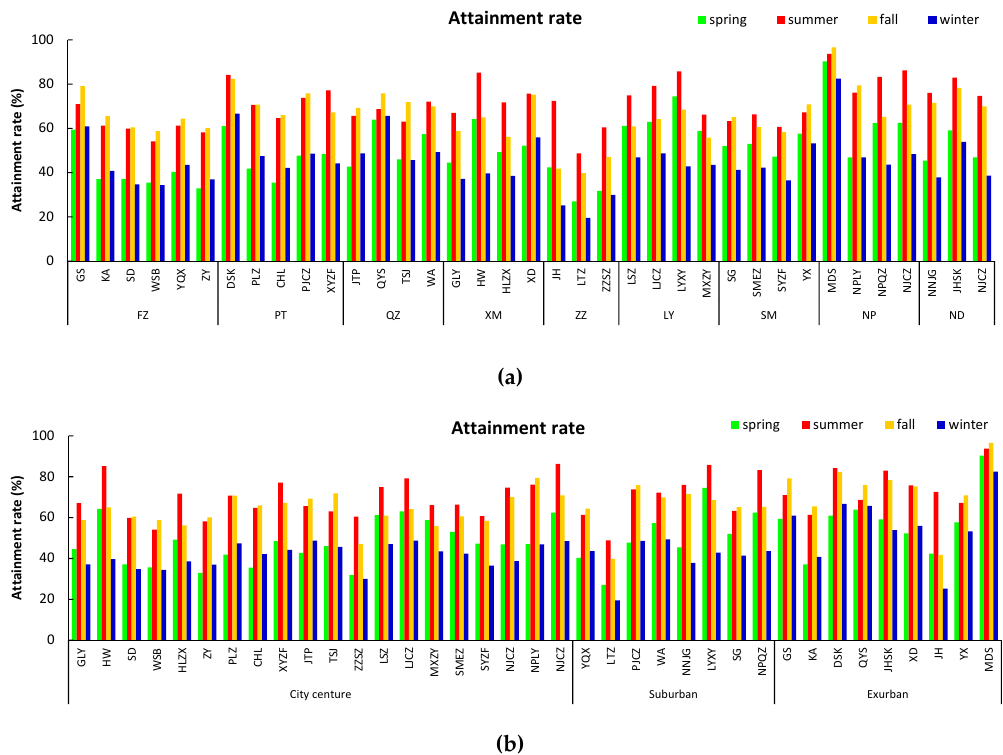
Figure 5. Seasonal variation of attainment rates ( a ) in the nine cities in Fujian province, ( b ) in the 37 stations classified into three region categories (city central areas, suburban areas and exurban areas).